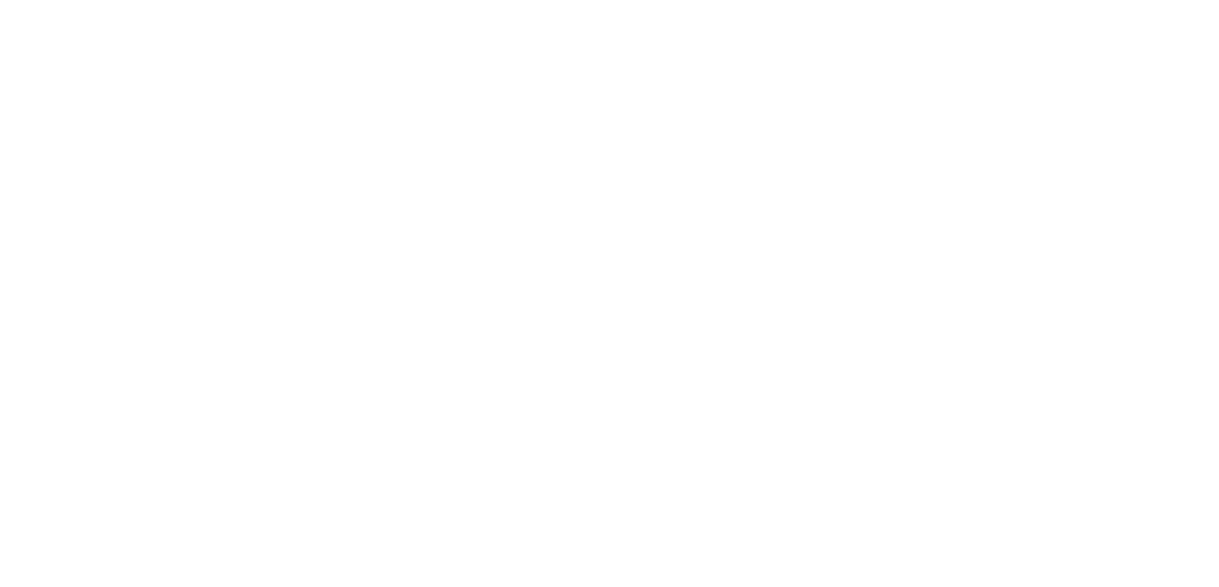
Frontiers in Energy Research | www.frontiersin.org